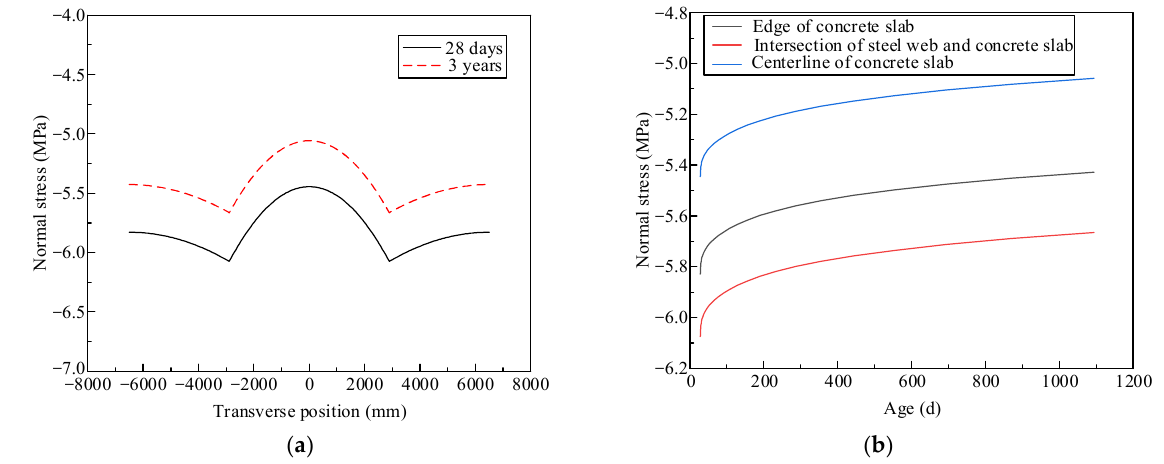
Figure 18 exhibits the stress distribution of the bottom flange of the steel beam and the change over time. Figure 18a shows that the stress at the steel web–concrete slab in- tersection increases from 96.349 MPa on the 28th day to 100.739 MPa in the 3rd year; the stress of the centerline of the steel bottom increases from 87.039 MPa on the 28th day to Figure 17. Stress on the concrete slab of the composite beam (time-dependent analysis). ( a ) Distri- 91.133 MPa in the 3rd year. Figure 18b shows the variation in these stresses with time and Figure 17. Stress on the concrete slab of the composite beam (time-dependent analysis). ( a ) Distribu- bution along width; ( b ) Change with time at mid-span section. reveals that the stress of steel slowly increases after the 400th day. tion along width; ( b ) Change with time at mid-span section.